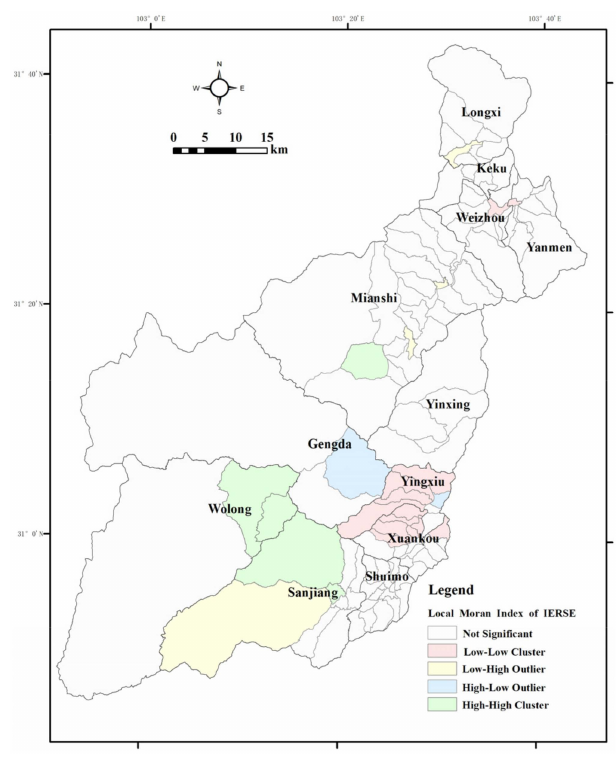
Figure 4. Local Moran Index of IERSE in Wenchuan